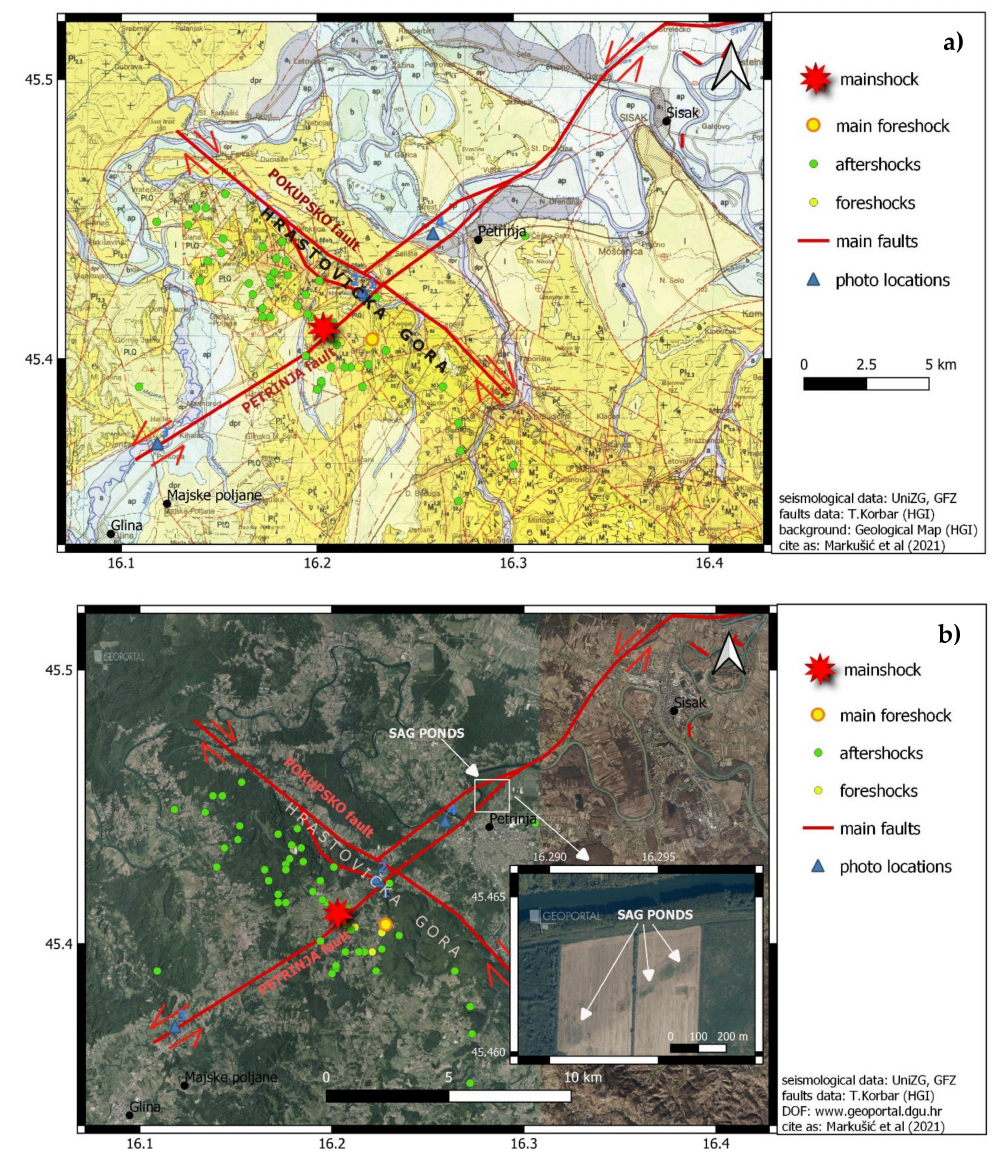
Figure 5. ( a ) A geological map of the Sisak, Petrinja and Glina areas in Croatia [14] with main faults (thick red lines) of the activated fault system highlighted, the activation of which caused earthquakes on 28 and 29 December 2020 (orange units = Paleogene (Pc, E), yellow units = Neogene (M), light yellow units = Quaternary loess (l) and colluvium (dpr), gray and light blue units = Quaternary alluvium (a, ap), light green units = palustrine); and ( b ) An interpreted orthophoto image [13] of the activated fault system that was captured a few years before the 2020 earthquakes. Numbers and blue triangles mark the positions of the field photographs that are shown in Figure 6: 1–6A, 2–6B, 3–6C, 4–6D. The inset shows sag ponds along the main creeping sinistral fault line, appearing on an active agricultural land (the orthophoto image is taken in